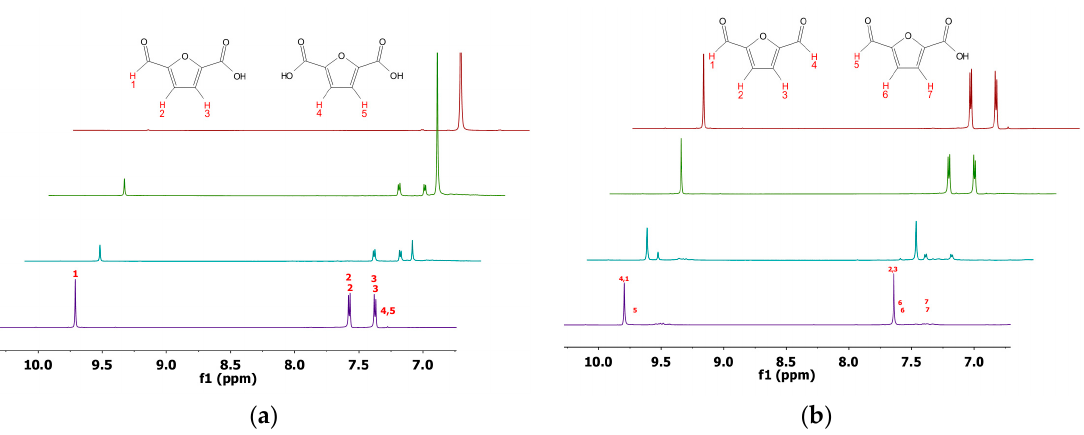
Figure 3. 1 H-NMR spectra of FFA ( a ) and DFF ( b ) conversions. Spectra in purple are the negative controls (without enzyme) and the product reference spectrum is in red. Green spectra are conversions with PAMO M446G and blue spectra are conversions with PAMO.